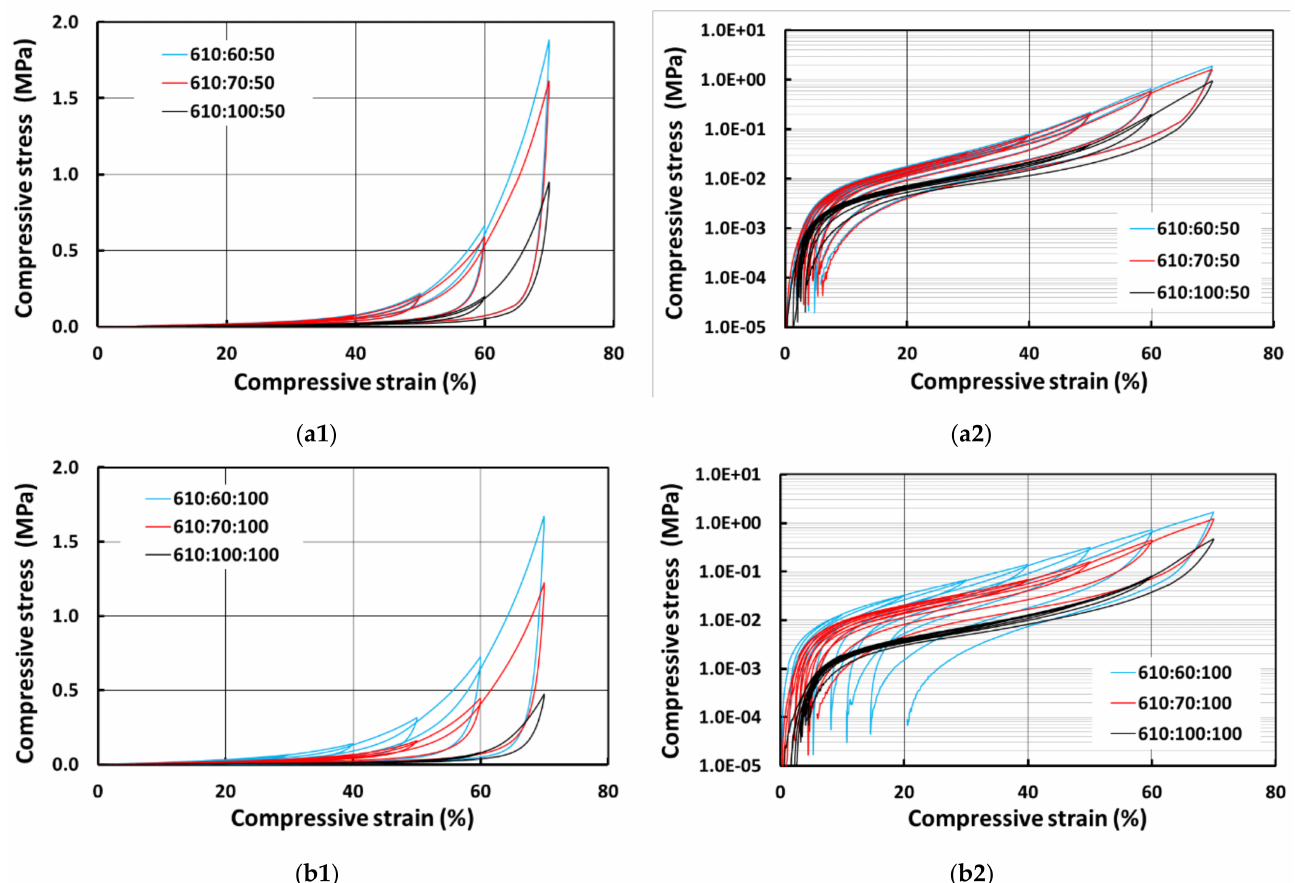
Figure 10. Compressive stress vs. strain curves for E610 samples prepared with 50% wetting hydrogel ( a1 ), its corresponding logarithmic plot of stress in ( a2 ) and 100% wetting hydrogel ( b2 ) and its corresponding logarithmic plot of stress in ( b2